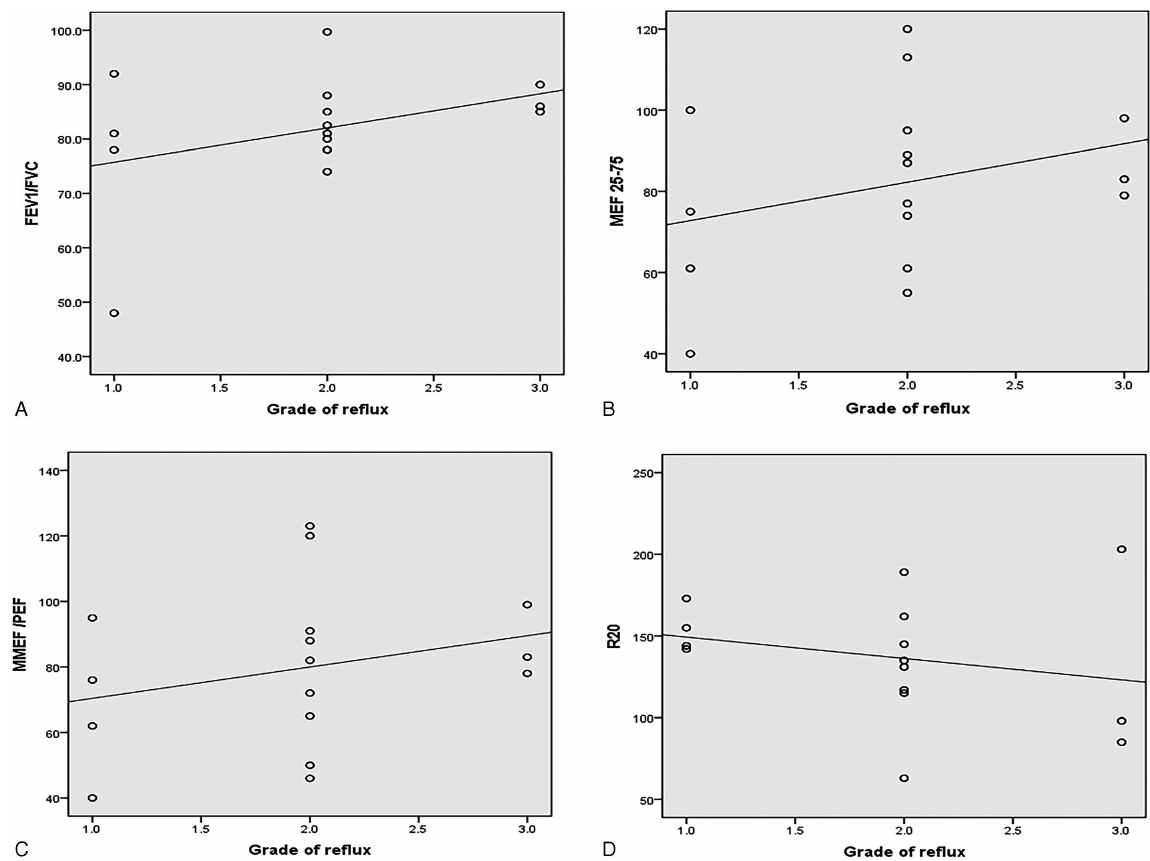
Diagrams that explain the correlation between grades of reflux and PFT parameters. FEV 1 , forced expiratory volume at the first second; FVC, forced vital capacity; MEF, maximum expiratory flow; MMEF/PEF, maximum mid-expiratory flow/peak expiratory flow; PFT, pulmonary function test; R20, respiratory resistance at high